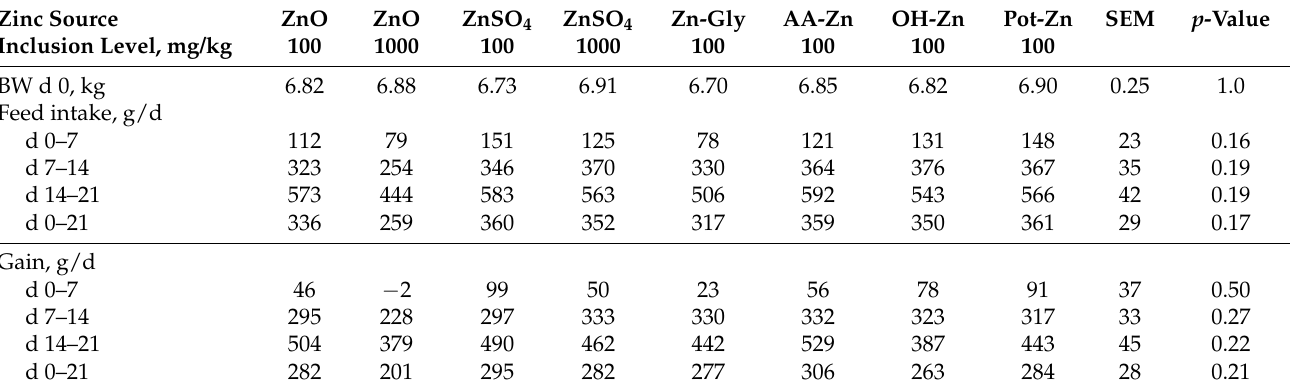
Table 3. Effect of different Zn sources and levels on feed intake and weight gain during d 0–7, d 7–14, d 14–21 and d 0–21. Least-square mean values with their standard errors, n = 12/teatment ( n = 11 for ZnSO 4 at 1000 mg/kg and